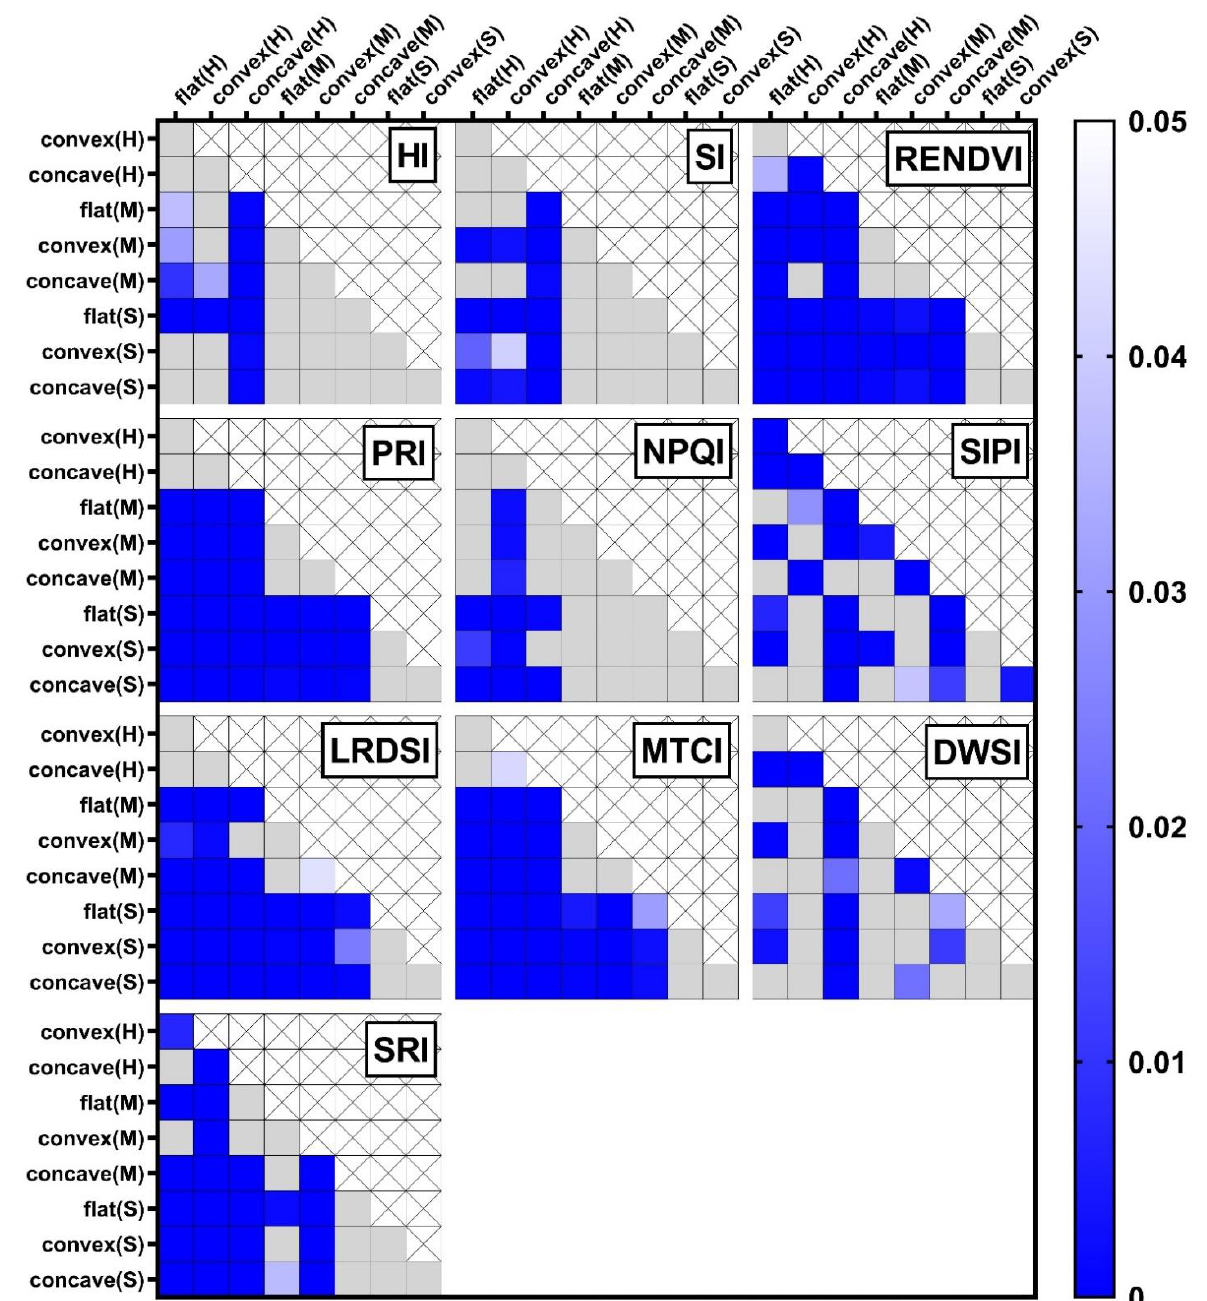
Figure 10. Heat map of p values for different indices calculated based on Dataset (C). H, M and S in x and y axis denote healthy, moderate and severe, respectively. Cross means no data, and gray box means not significant.